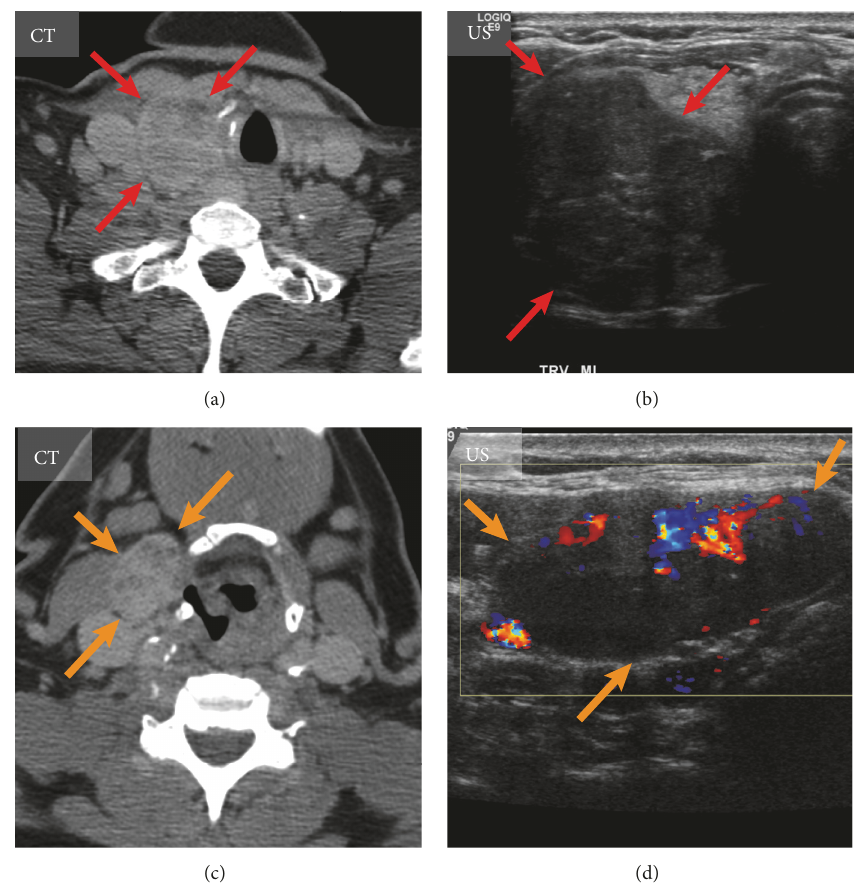
Figure 4: Imaging of the medullary thyroid carcinoma with metastasis to lymph node. Medullary thyroid carcinoma of the right thyroid lobe (red arrows) visualized on axial computed tomography (CT) (a) and transverse ultrasound (US) scan (b). A large metastatic lymph node (orange arrows) is demonstrated on axial CT of the neck (c) and sagittal US